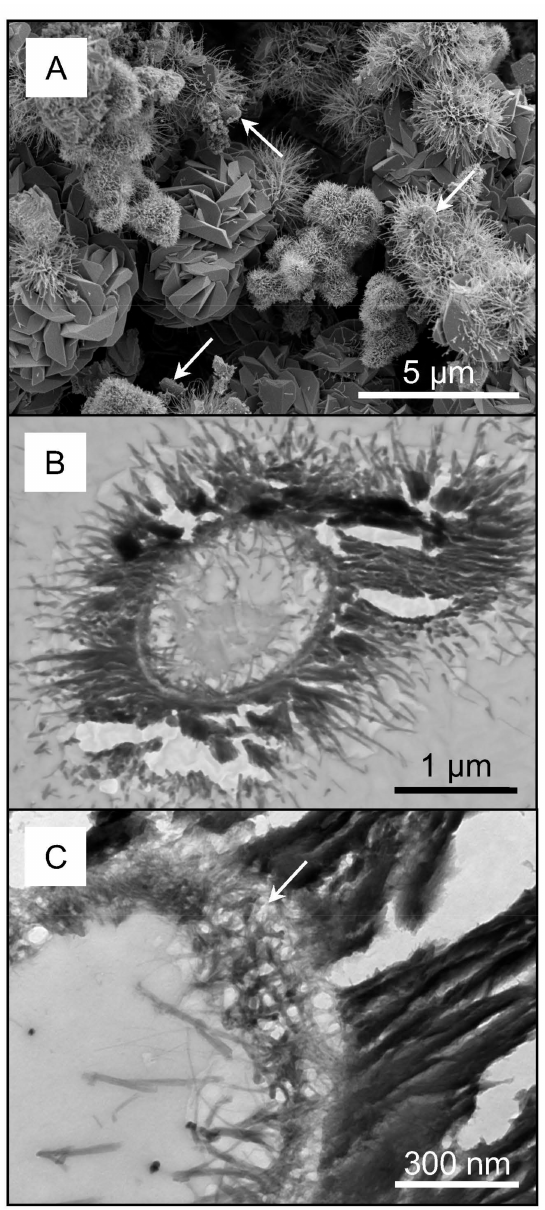
Figure 4. A low-resolution SE SEM micrograph of euhedral hydronium jarosite and poorly-crystalline, i.e., pseudo-acicular, schwertmannite and cells (arrows) from the microbial enrichments ( A ); a low-resolution TEM micrograph of a bacterium extensively mineralized pseudo-acicular schwertmannite ( B ); a high-resolution TEM micrograph demonstrating the preservation of the cell wall (arrow, C ) and the lesser amount of intracellular mineralization relative to the extracellular surface ( C